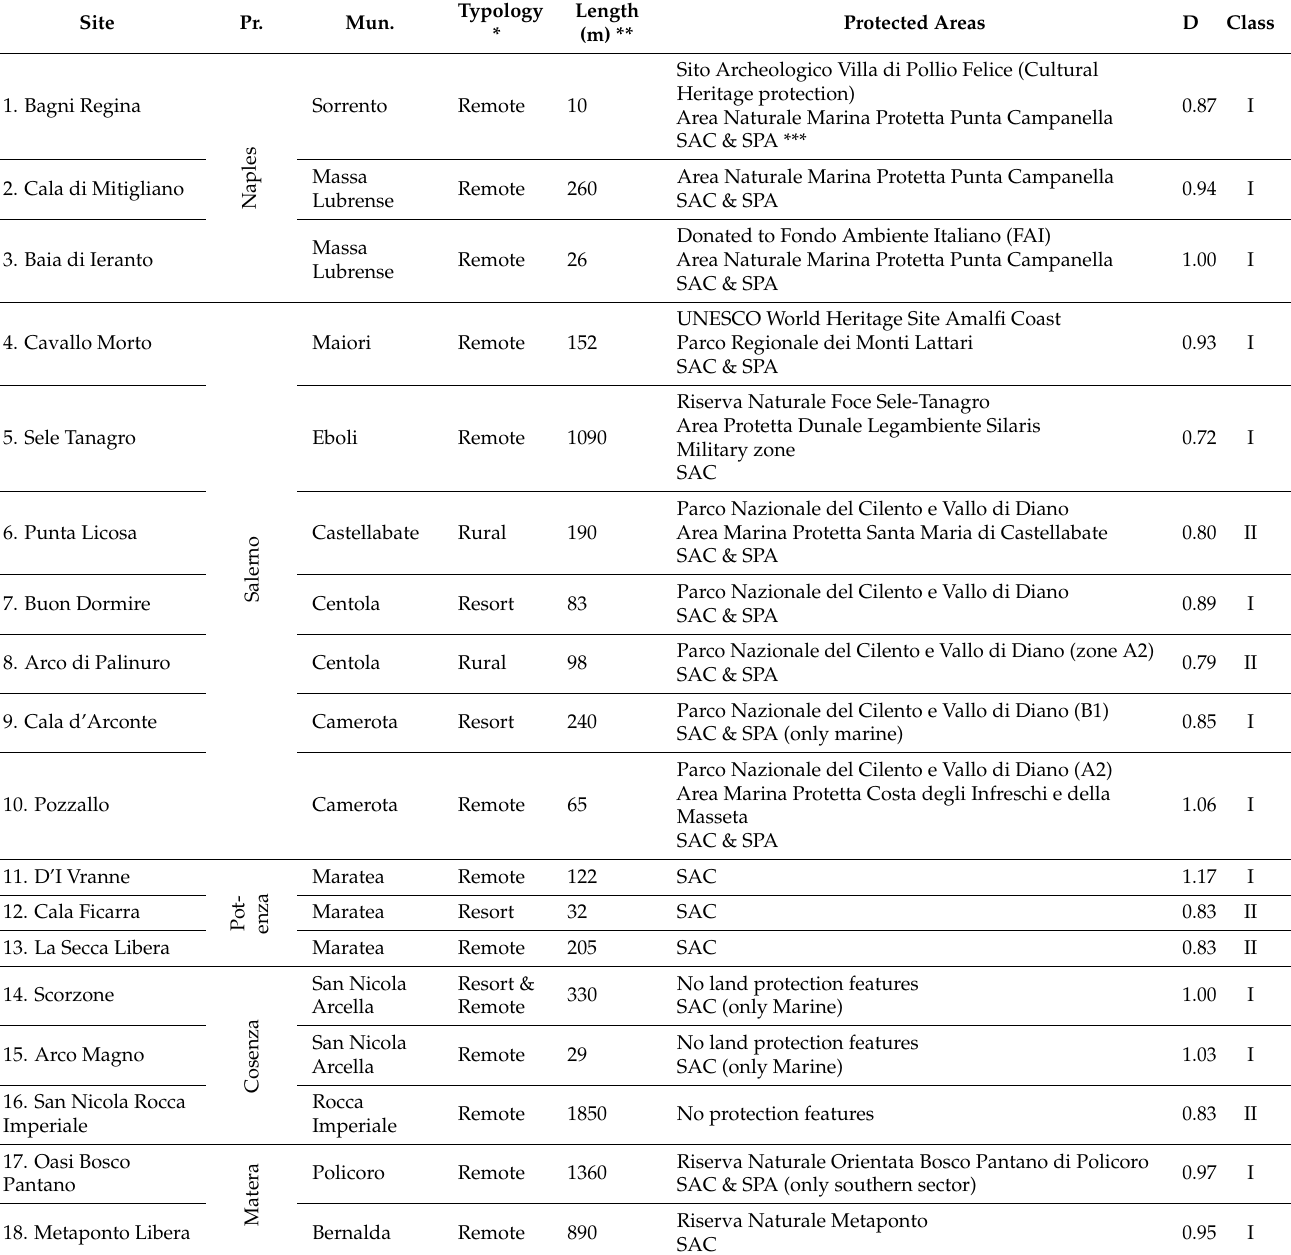
Table 1. General sites characteristics with corresponding location map numbers: province (Pr.), municipality (Mun.), beach typology, coastal length, protected areas and Coastal Scenic Evaluation System (CSES) results, i.e., “D” value and Class, see Methods for explanation. Typology Length Site Pr. Mun. * (m)